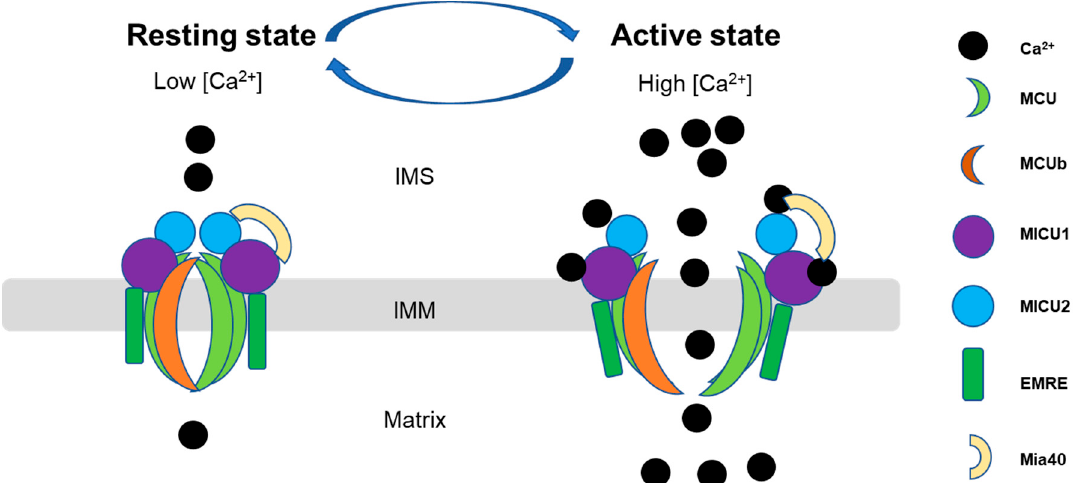
Figure 2. Scheme of the dynamic function of the mitochondrial calcium uniporter (MCU) complex. Mitochondrial Ca 2+ uptake is controlled by a multiprotein complex which locates as a transmembrane pore in the inner membrane, consisting of the pore-forming subunits (MCU and MCUb), structural protein (the essential mitochondrial Ca 2+ uniporter regulator (EMRE)) and Ca 2+ sensitive proteins (the mitochondrial Ca 2+ uptake (MICU)). MCU- complex mediated Ca 2+ entry into mitochondria in a Ca 2+ - dependent manner: at low Ca 2+ in the resting state, Mia40 introduces an intermolecular disulfide bond that links MICU1 and MICU2 in a heterodimer, which binds to MCU to ensure MCU gatekeeper activity, preventing mitochondrial Ca 2+ from entering into the mitochondrial matrix ( left ). Upon an increase in Ca 2+ concentrations in the IMS, Ca 2+ binding to the MCIU1-MICU2 dimer leads to structural changes that lower the affinity toward MCU, dissociates MICU proteins from MCU, and actives MCU channel activity, allowing efficient mitochondrial Ca 2+ uptake ( right ) [51,77]. IMS, intermembrane space; IMM, inner mitochondrial membrane.